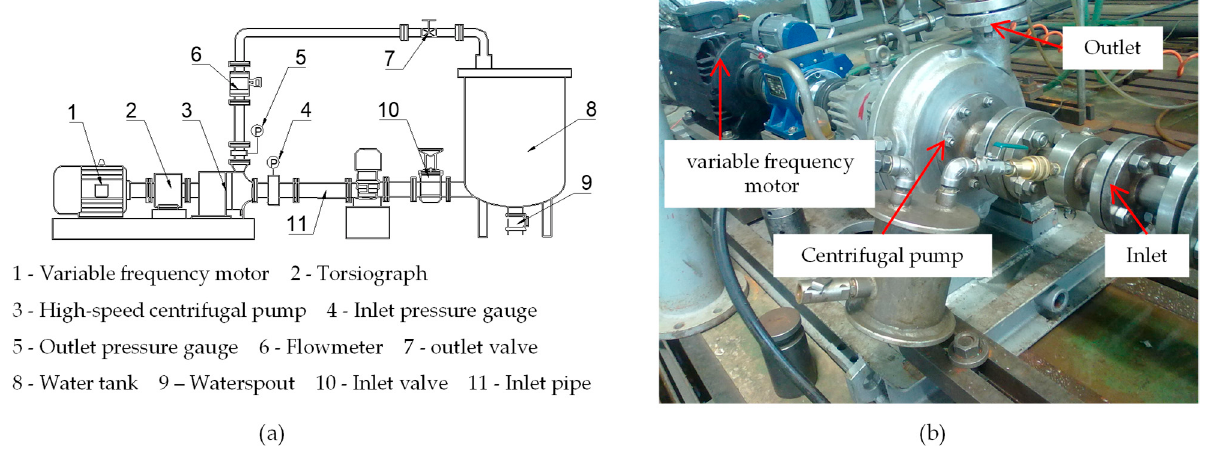
Figure 2. The closed test-bed and test systems: ( a ) Closed test-bed system; ( b ) Test bed.